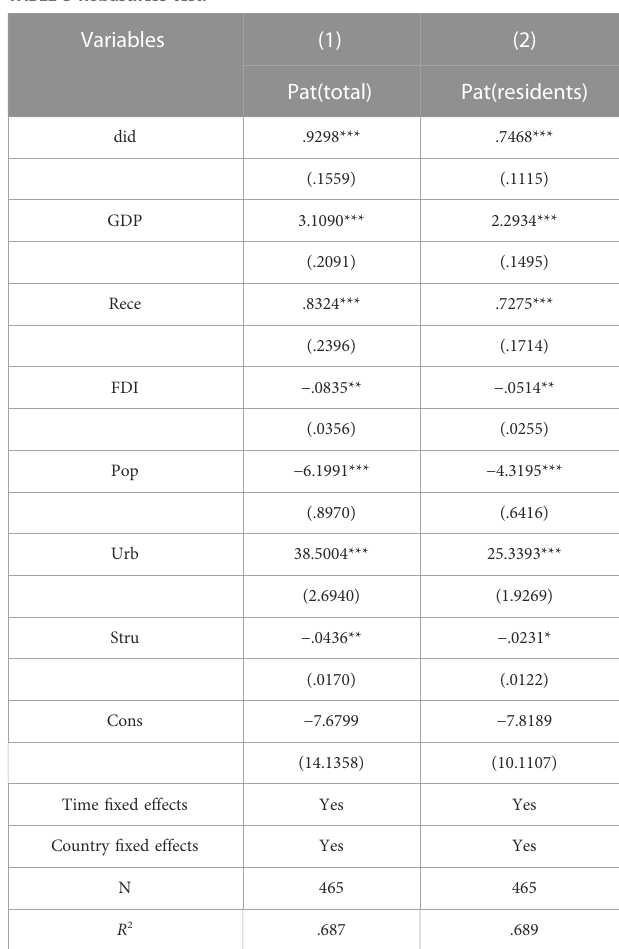
TABLE 5 Robustness